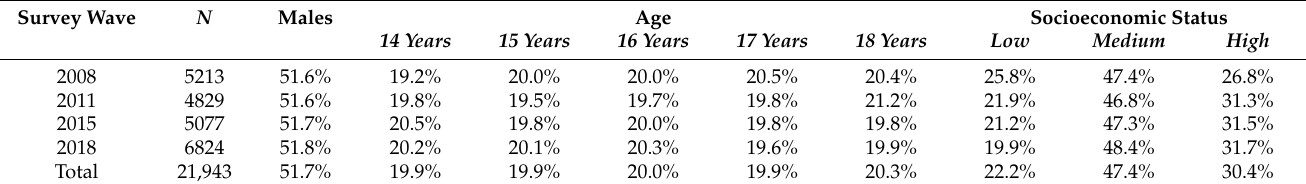
Table 1. Sociodemographic characteristics of the study sample (survey waves 2008, 2011, 2015, and 2018). Survey Wave N Males